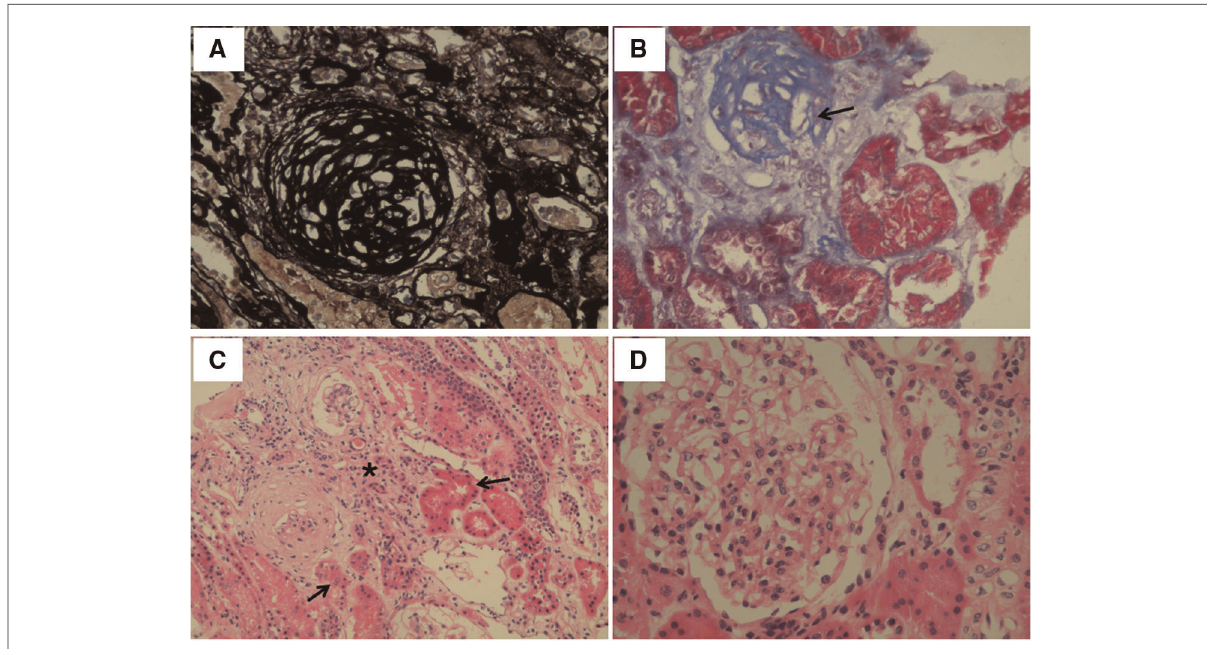
FIGURE 1 Light microscopy images of kidney tissue. ( A ) Globally sclerostic glomeruli. Silver ×400. ( B ) Globally sclerotic glomeruli (arrow). Masson Trichrome ×400. ( C ) Tubular atrophy (arrow) and renal interstitial fi brosis (star). Hematoxylin-eosin ×200. ( D ) Proliferation of mesangial cells and segmental accumulation of matrix. Hematoxylin-eosin